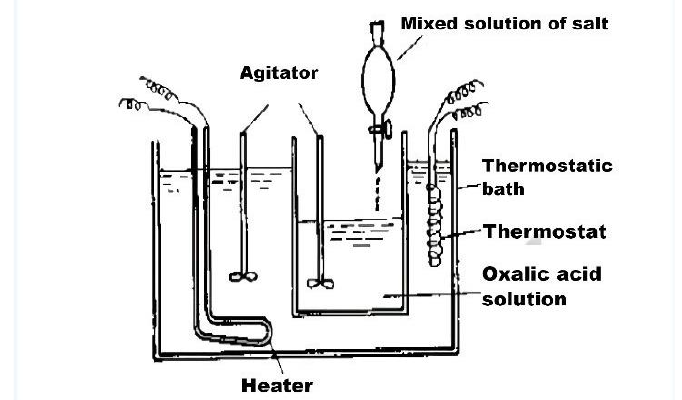
Figure 10. Diagram of compound precipitation synthesis device.